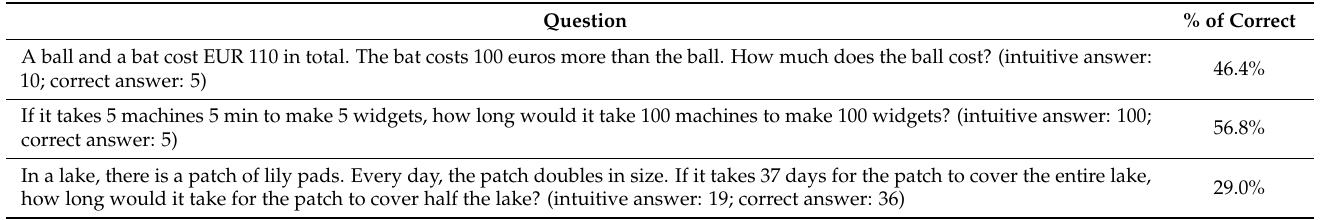
Table A4. Cognitive Reflection Test questions.